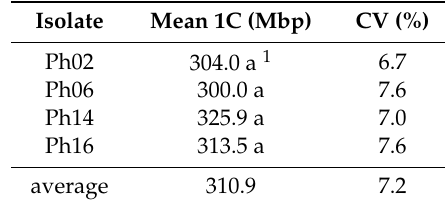
Table 4. Genome size (in Mbp, and the corresponding coefficient of variation, CV) of four Puccinia hemerocallidis isolates.